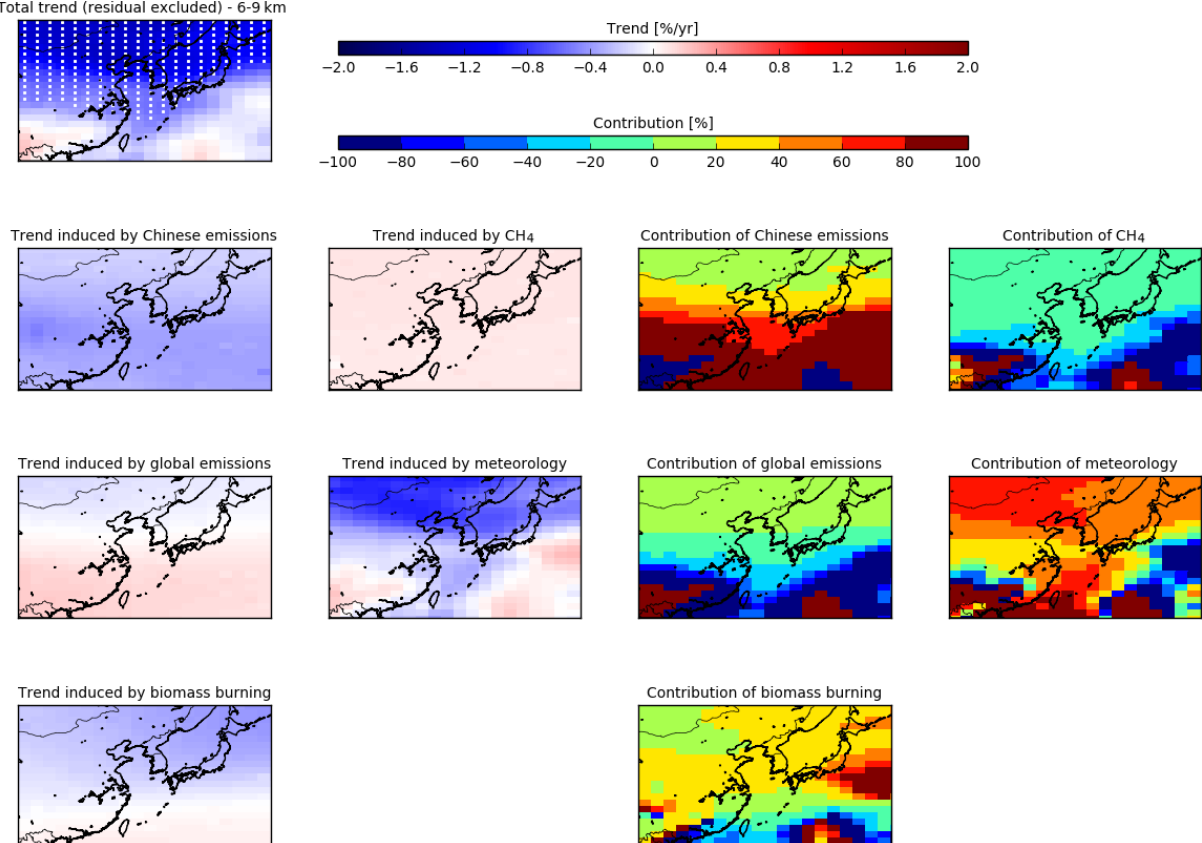
Figure B2. Trends and contributions of the meteorological variability, the Chinese anthropogenic emissions, the global anthropogenic emis- sions, the global biomass burning emissions, and the CH 4 to the trends calculated for the 3–6km (see Table 4 for details on the sensitivity tests). The residual trend and its contribution is also